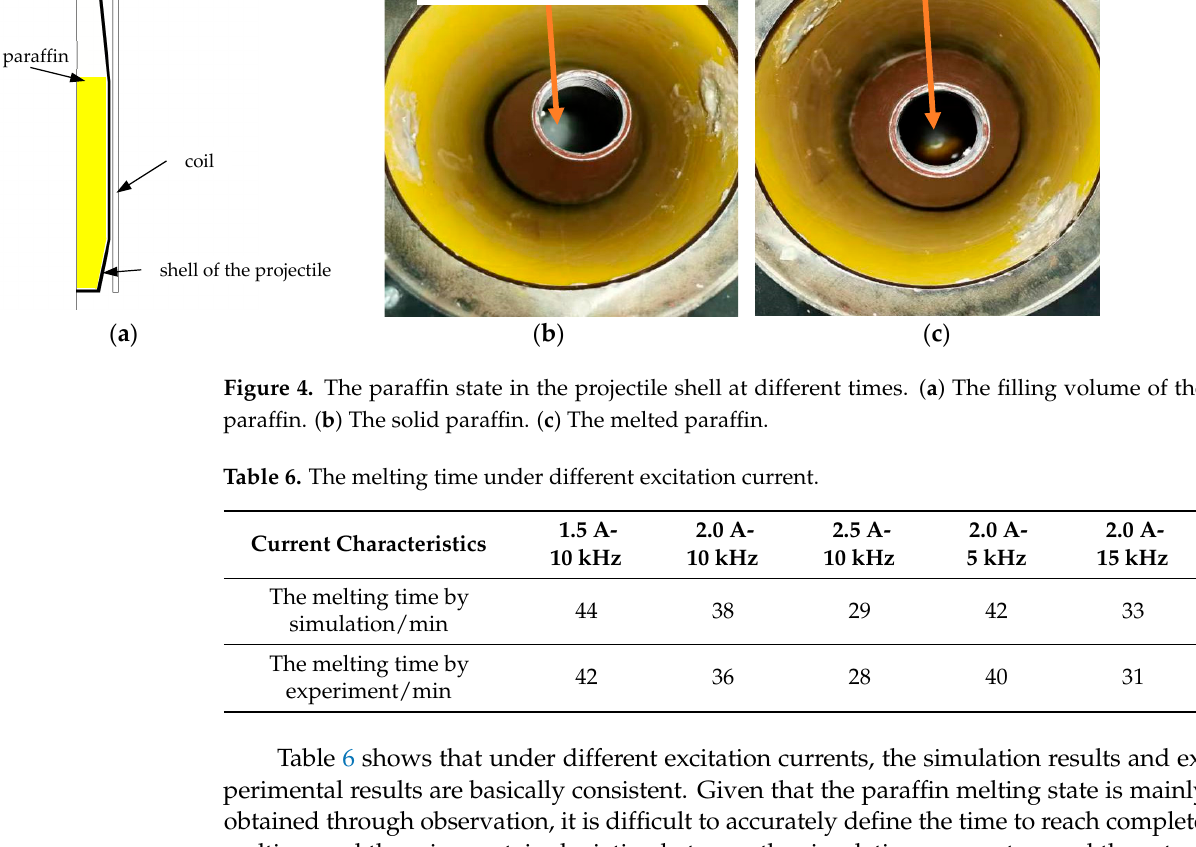
( b ) Figure 3. The experimental system based on the electromagnetic heating method. ( a ) The electro- magnetic heater. ( b ) The control system.